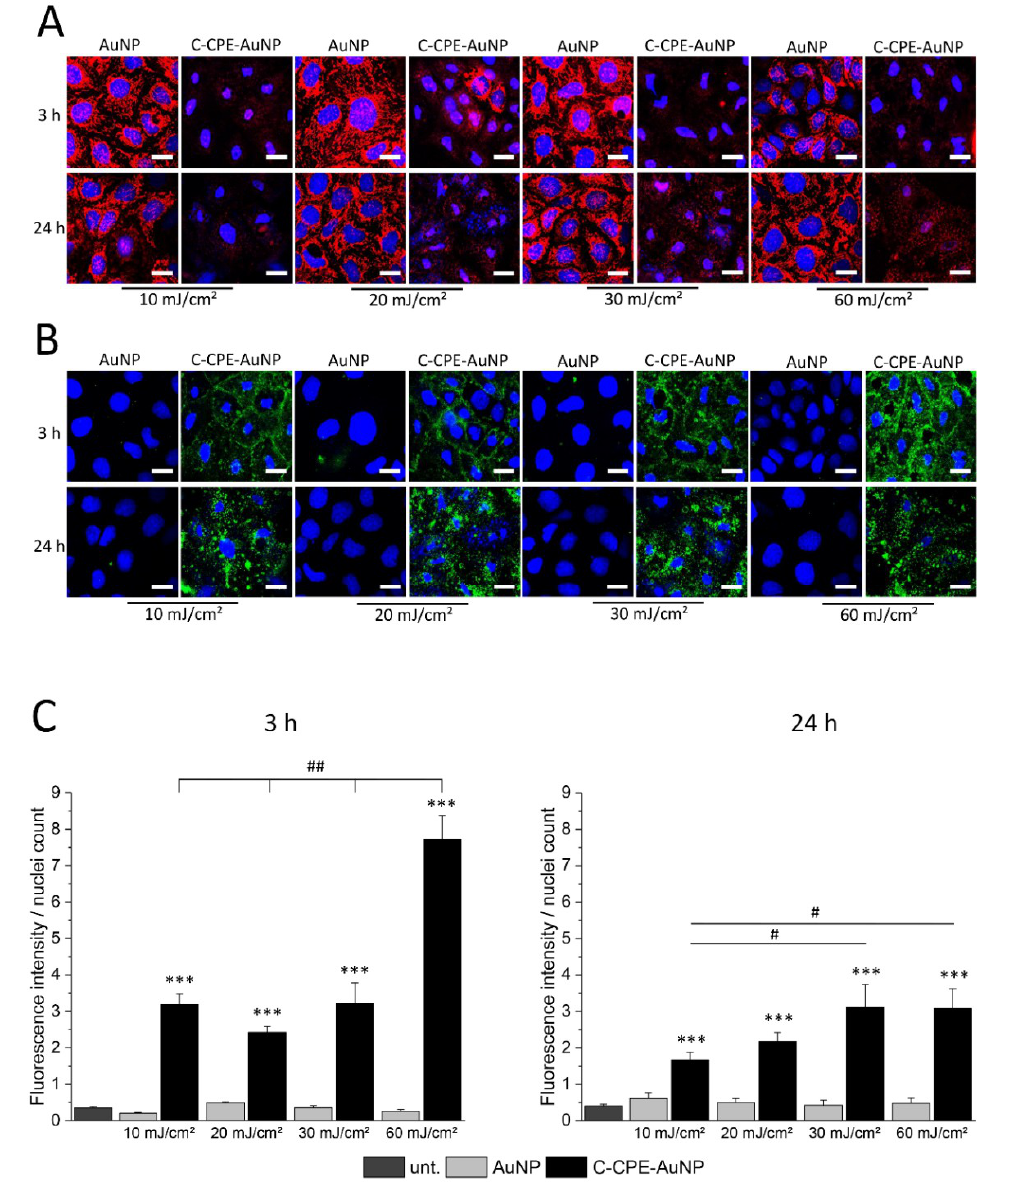
Figure 3. GNOME-LP in presence of C-CPE-AuNPs affected the annexin V and MitoTracker staining of the cells. ( A ) Independent of the applied laser fluence, 3 h and 24 h after GNOME-LP treatment in the presence of C-CPE-AuNPs reduced MitoTracker™ Orange mitochondria labeling (red) and ( B ) induced annexin V Atto488 staining of cells (green). Remark the shrinkage of the nuclei (blue) in cells treated with GNOME-LP in presence of C-CPE-AuNPs. Nuclei were stained with Hoechst. Scale bar,